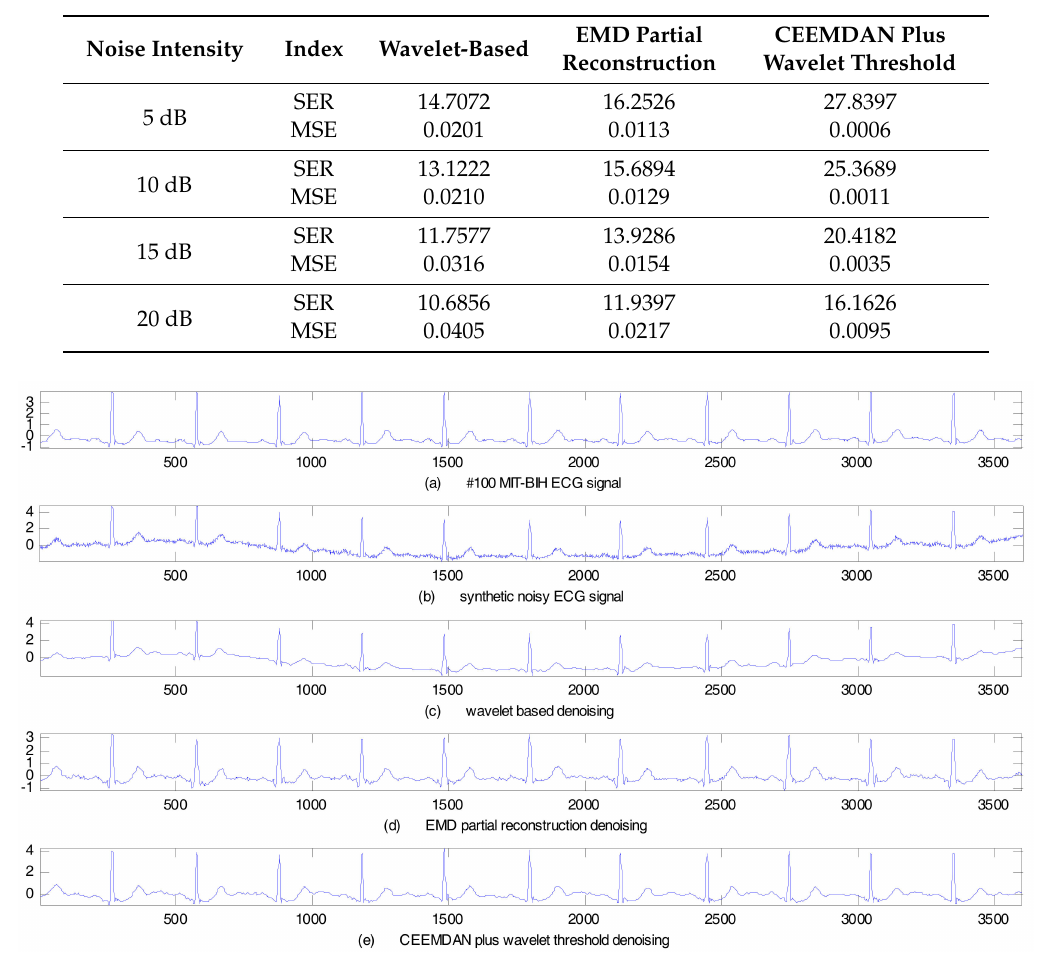
Table 3. Performance indices under different noise intensity (No. 103 MIT-BIH ECG).